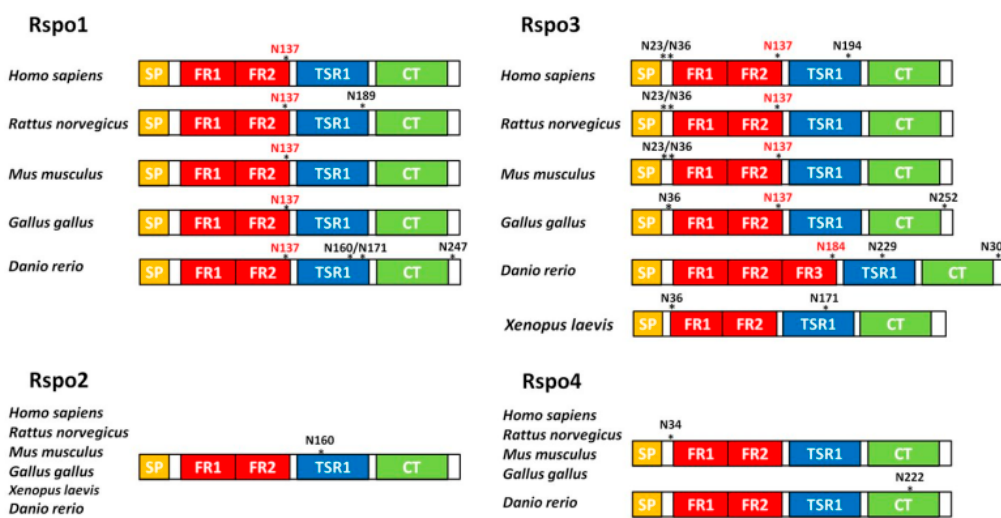
Figure 2. Location of the sequons in human Rspo family. ( A ) The location of conservative sequons (N137) among the vertebrate Rspo1 and Rspo3 family members and the unique sequon (N160) in Rspo2 members. All Rspo proteins contain an N-terminal signal peptide (SP), two furin-repeat domains (FR1 and FR2; also collectively known as the cysteine-rich domain, CRD), one thrombospondin type 1 domain (TSR1), and a C-terminal region enriched with positively charged amino acids (CT). One exception is that teleost Rspo3 members contain one additional furin repeat (FR3) (shown in B ). Amino acid sequences located around the N137 (in Rspo1 and 3) and N160 (in Rspo2) are shown in boxes. Putative sequons are denoted in red. Hs: Homo sapiens ; Rn: Rattus norvegicus ; Mu: Mus musculus ; Gg: Gallus gallus ; Dr: Danio rerio ; ( B ) Schematic illustration of the sequons in Rspo family. The potential sequons are marked by asterisks. The conserved N137 sites are shown in red.